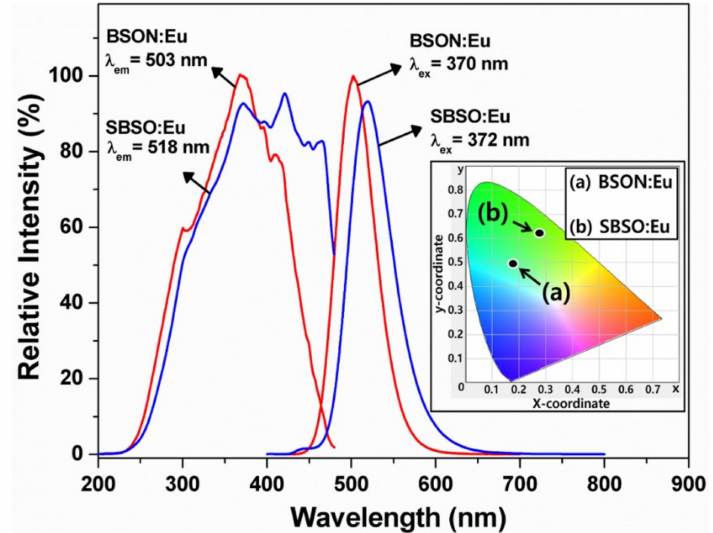
Figure 12. PL spectra of BSON:Eu 2 + and a commercial (Sr,Ba) 2 SiO 4 :Eu 2 + (SBSO:Eu) phosphor (obtained from Force4 Co., Ltd. in Korea). The inset shows CIE coordinates of BSON:Eu 2 + and (Sr,Ba) 2 SiO 4 :Eu 2 +